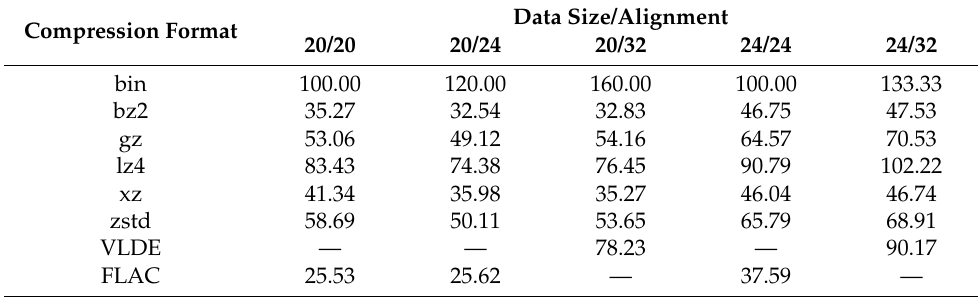
Table 1. Off-line data compression ratio (percentage) for different compression algorithms and bit depths, applied to the original (non-differentiated) signal. Columns represent different data size/alignment